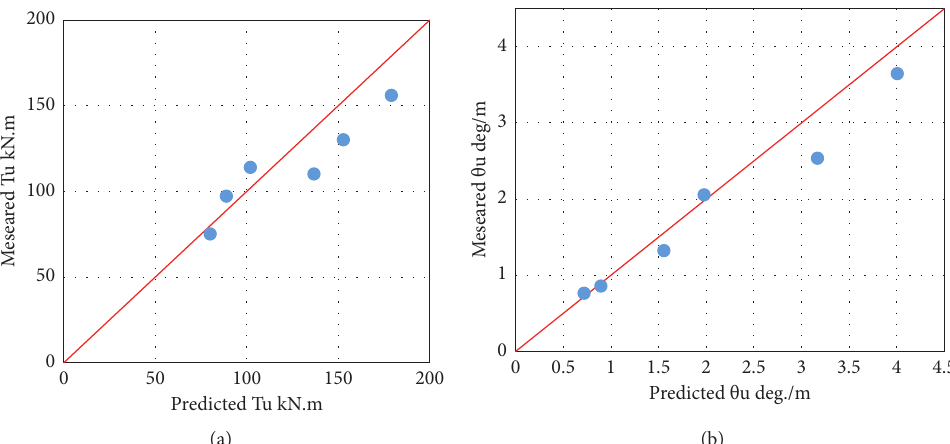
Figure 11: Measured and predicted ultimate torque and angle of twisting. (a) Measured T predicted θ u